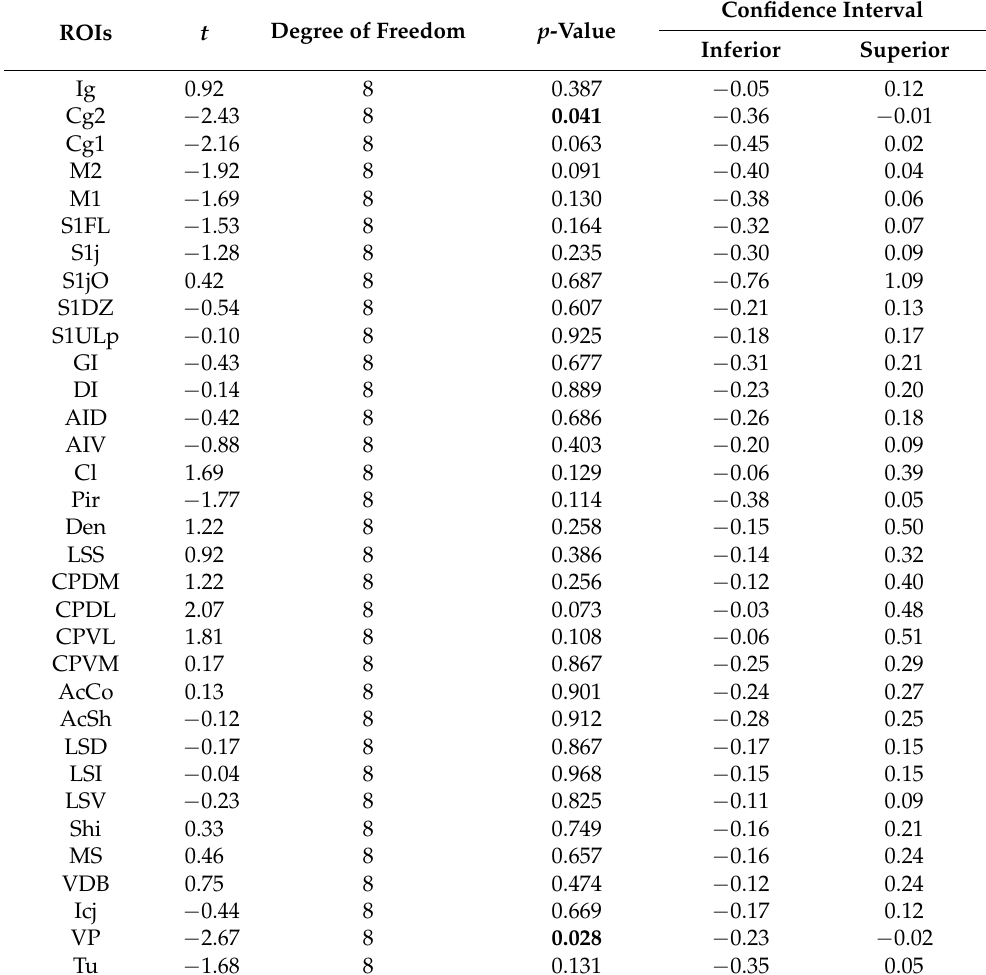
Table 3. Results of Student’s t test comparing the VEH/VEH vs. VEH/ASE groups throughout the 33 regions of interest. Significant values were outlined in bold. ROIs: regions of interest. ROIs t Degree of Freedom p -Value